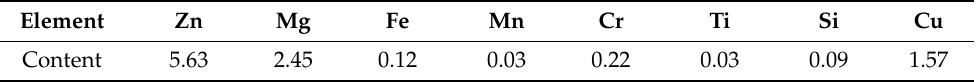
Table 1. Chemical Composition of AA7075 (wt.%) Bar Samples That Were Used for This Study. Element Zn Mg Fe Mn Cr Ti